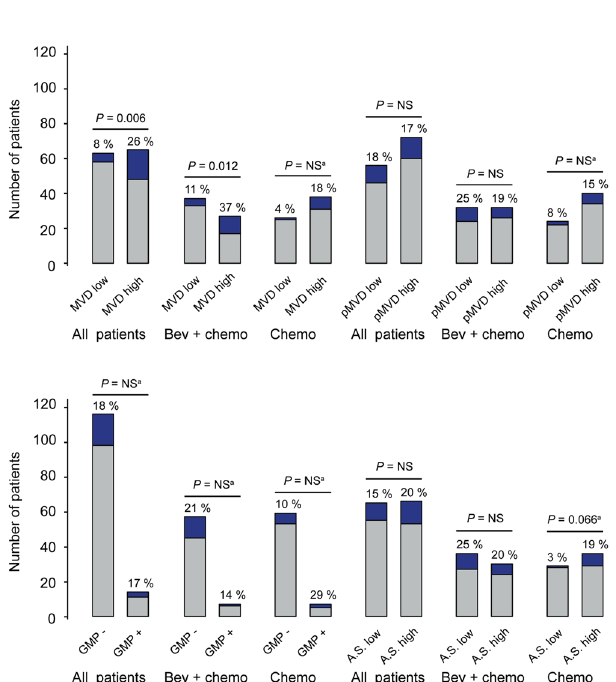
Figure 3. pCR according to MVD, pMVD, GMP and the 32-gene angiogenesis signature score. Each bar represents number of patients by high and low biomarker for all patients, the bevacizumab-arm (Bev + Chemo), and the chemotherapy only-arm (Chemo). pCR (pathologic complete response) rates are presented by %-estimates and indicated by dark blue color. P values by Pearson’s chi-square ( χ 2 ) test or Fisher’s exact test. a Fisher’s exact test. MVD microvessel density, pMVD proliferative microvessel density, A.S. angiogenesis signature score. Median as cut-off